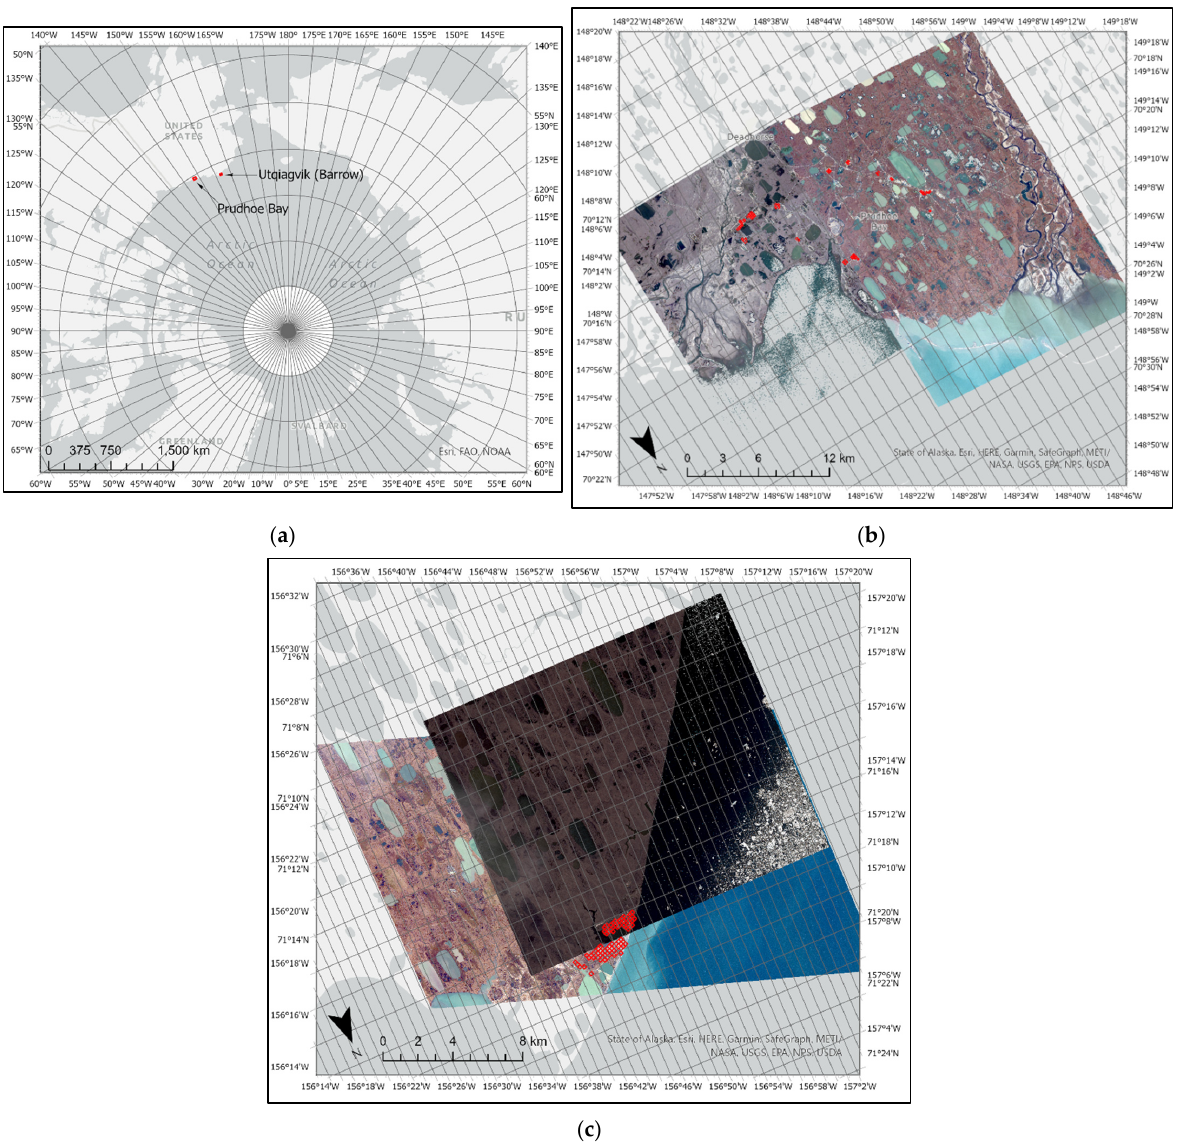
Figure 1. ( a ) Inset map showing both study sites within the extent of the Arctic, with red boxes indicating each site. ( b , c ) depict the Utqiagvik and Prudhoe Bay study sites, respectively, and the satellite images (natural color composite) used to train and test the U-Net CNN. Annotated areas are outlined by red boxes. Imagery © DigitalGlobe, Inc.